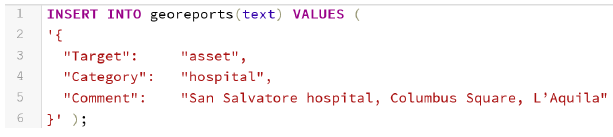
Figure 11. An instance of the three JSON